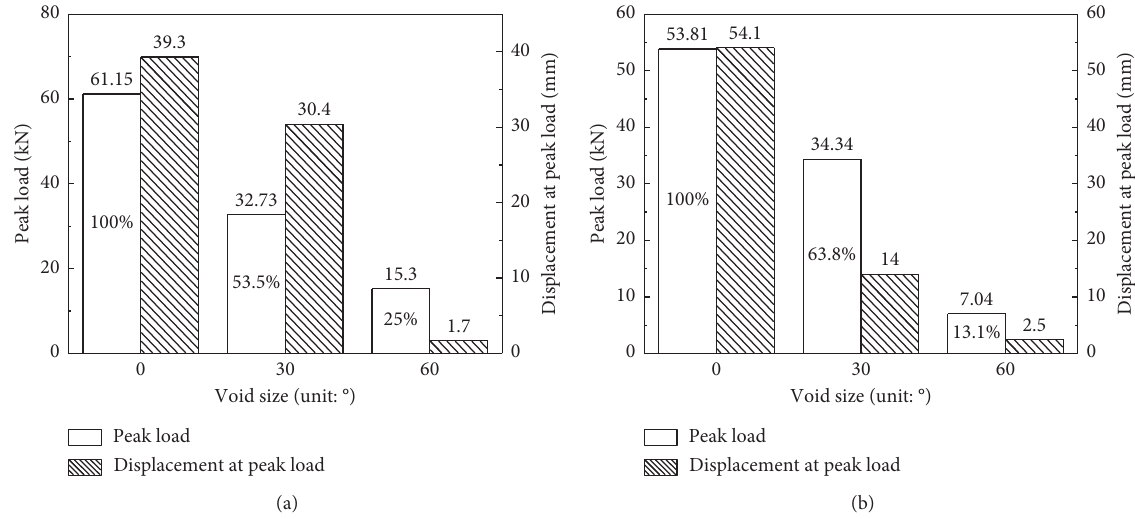
Figure 8: Peak load and the corresponding displacement of the lining with different void sizes: (a) crown and (b)